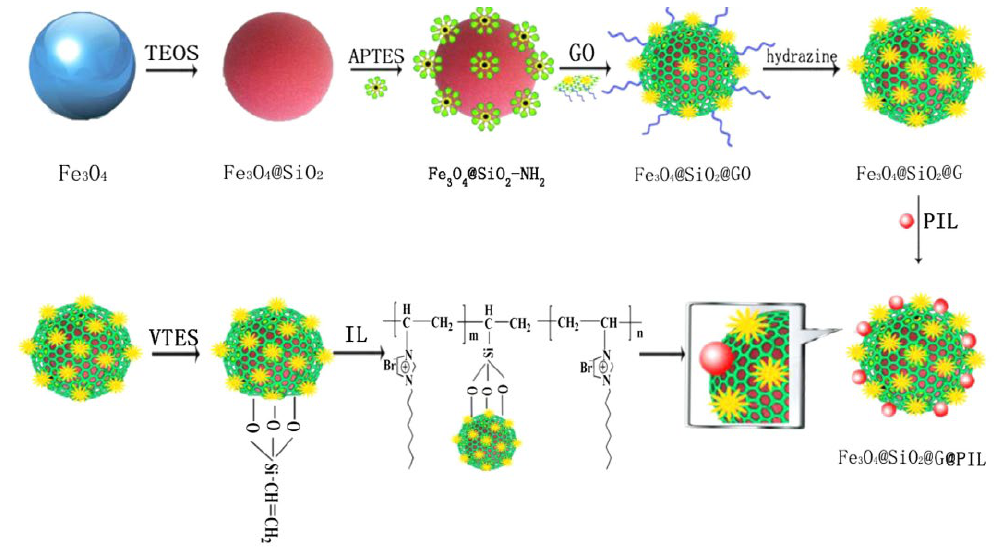
Fig. 7. Preparation of magnetite nanoparticles by a graphene and polymeric ionic liquid coating [71].